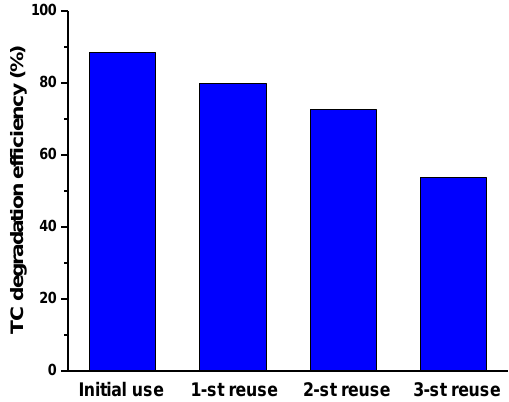
Figure 7. TC degradation efficiency (%) of ZnO/γ-Fe 2 O 3 composite material cycled for three times after 150 min of light irradiation.